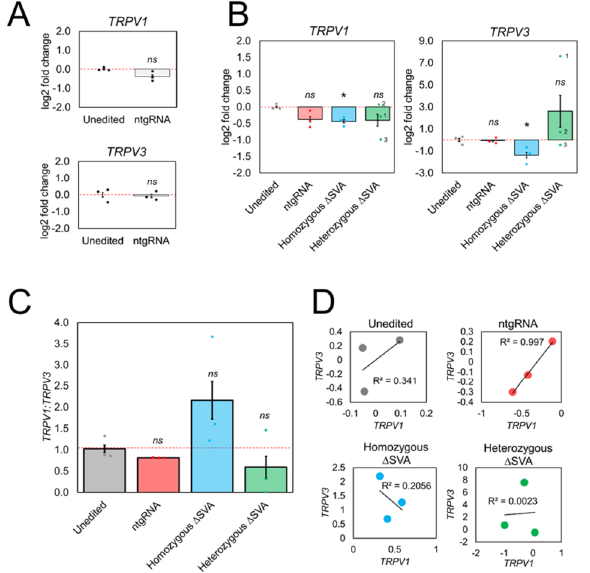
Figure 4. Clustered regularly interspaced short palindromic repeats (CRISPR)-mediated deletion of SVA in HEK293 disrupts co-expression of TRPV1 and TRPV3 mRNA. ( A ) TRPV1 and TRPV3 mRNA expression in cells transfected with ntgRNAs compared to unedited HEK293. ( B ) mRNA expression in unedited cells, ntgRNA controls, homozygous ∆ SVA clones, and heterozygous ∆ SVA clones. ( C ) Ratio of TRPV1 : TRPV3 mRNA levels. ( D ) Pearson’s correlation of TRPV1 and TRPV3 mRNA in all cell lines. Abbreviations; not significant (ns), * p -value < 0.05 (2-sample t